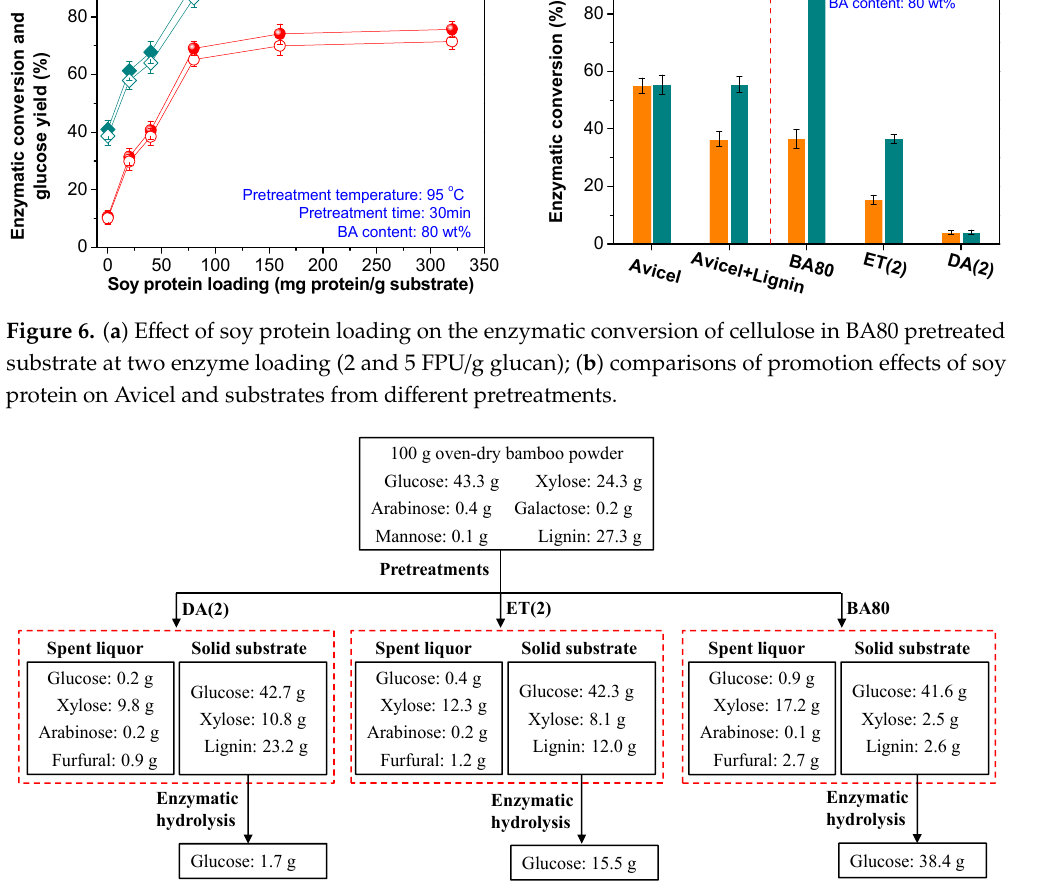
Figure 8. ( a ) Zeta potential and particle size of cellulase, BA80 lignin, soy protein and their mixtures; ( b ) a schematic diagram for promoting the enzymatic conversion of cellulose in BA80 pretreated solid substrate by using soy protein.